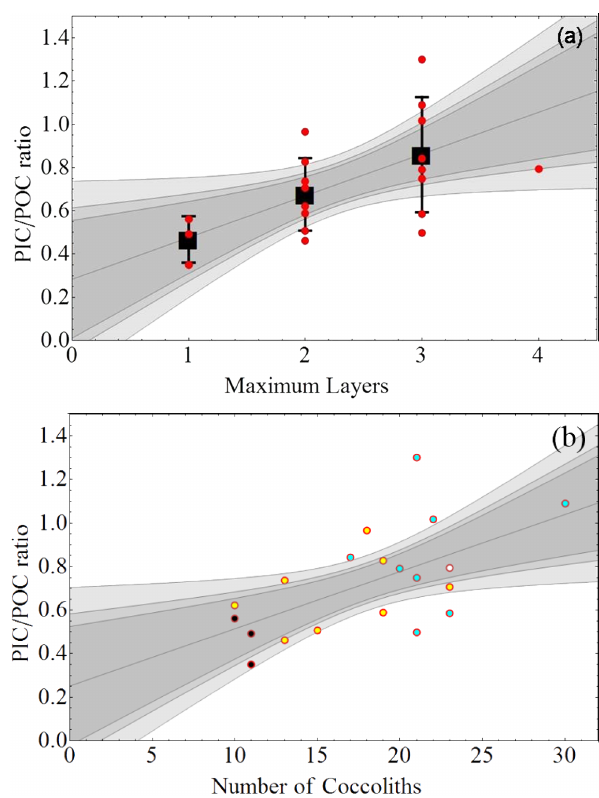
Figure 7. The overall cell density as function of the PIC / POC ratio is plotted in (a) . The black line illustrates a linear trend that was as- sumed in the literature (Paasche, 1998). The linear regression is de- scribed by: density = 0 . 08 × (PIC/POC) + 1.16 ( r 2 = 0 . 10). In (b) the sinking velocity is plotted as a function of the PIC / POC ratio. The fitted slopes as well as the calculated 0.9, 0.95 and 0.99 con- fidence levels are given by the grey lines. The linear regression is described by: sinking rate = 2593 × (PIC/POC) + 1986 ( r 2 = 0 .